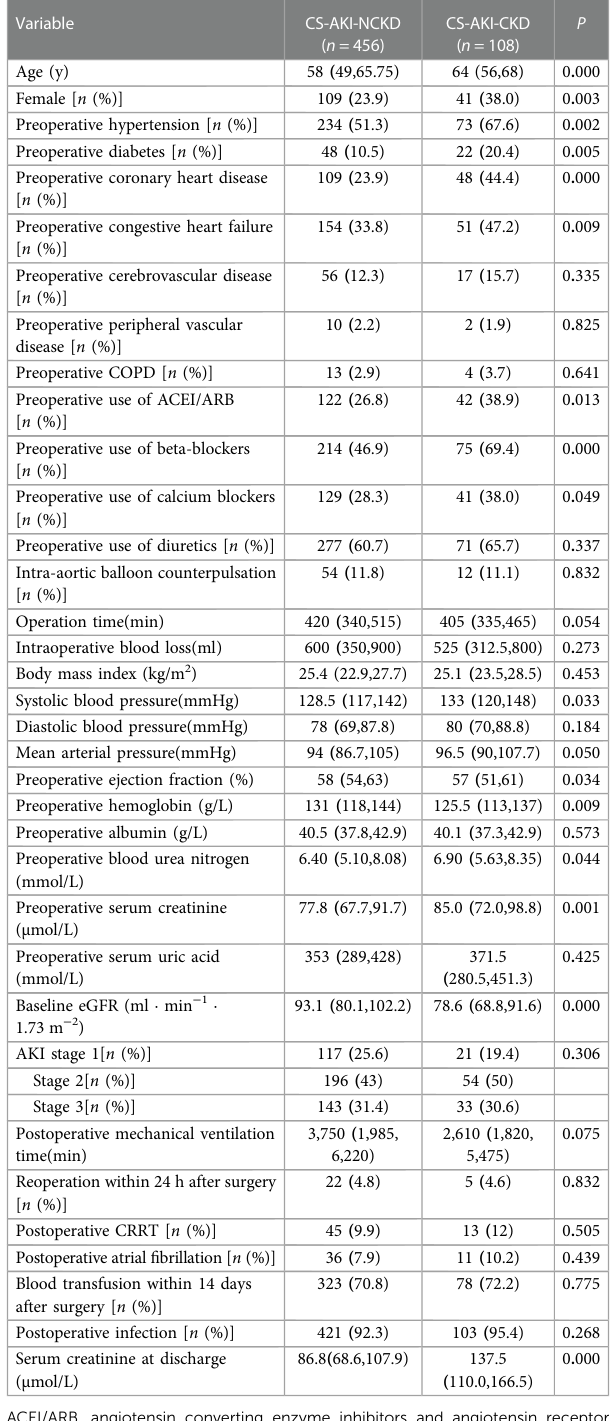
TABLE 1 Comparison of baseline clinical characteristics of patients in CS- AKI-CKD group and CS-AKI-NCKD